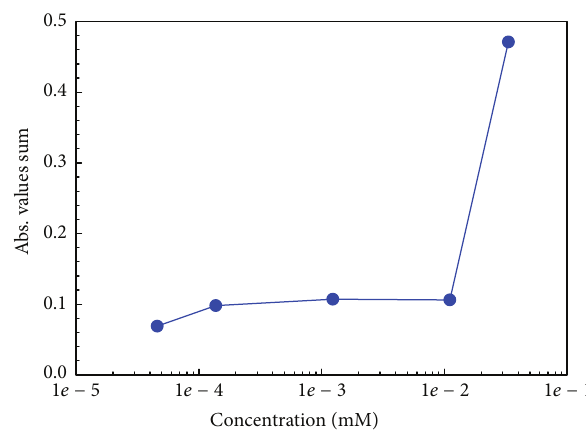
Figure 2: CMC measurement result of MPD